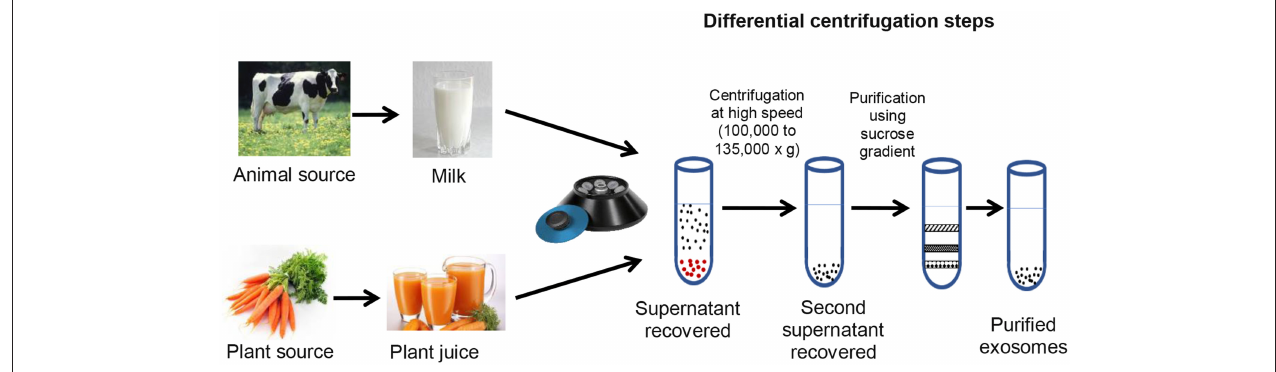
FIGURE 2 | Sources, isolation and purification of exosomes and exosome-like